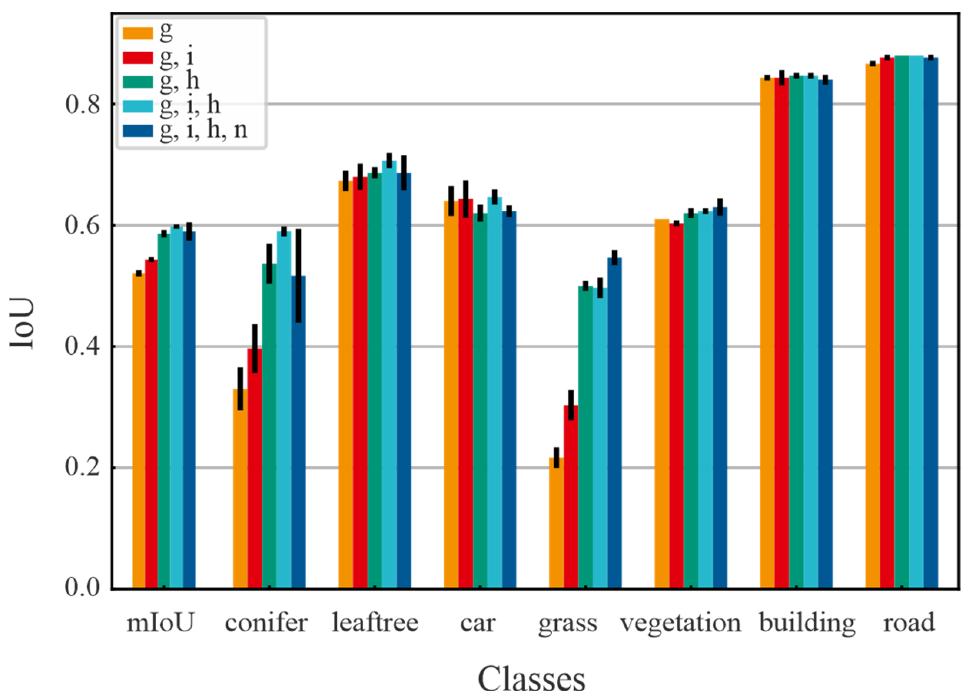
Figure 5. Visualization of the training results. Here the mIoU and the IoU of each class is shown for the trainings using just geometry (g), geometry and intensity (g, i), geometry and DAV (g, h), geometry, intensity and DAV (g, i, h) and geometry, intensity, DAV and number of points (g, i, h, n). The black bars indicate the standard deviation calculated from the three separate trainings for each setting. Similar plots for the precision, recall and F1 score can be found in the appendix.